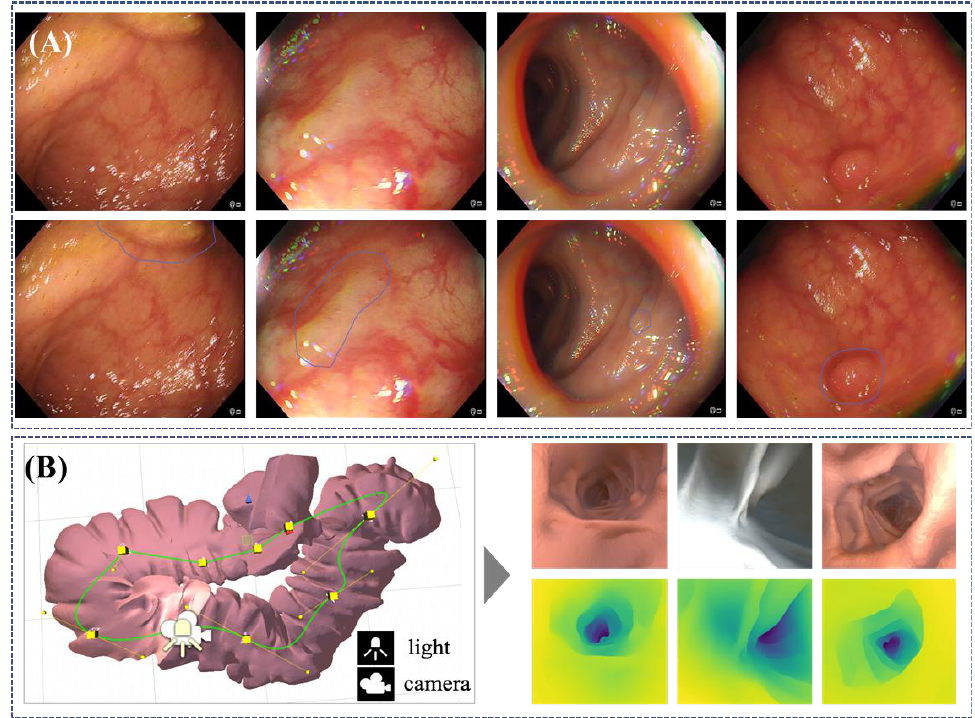
Figure 7. Illustration of the use of AI techniques on endoscopic images. ( A ) Shows an AI model that automatically highlights regions in the endoscopic images which are potentially occupied by a polyp; (top) original images, and (bottom) images with AI predicted regions (Courtesy of Prof. Danail Stoyanov). ( B ) Shows simulation data generated for a virtual colon, which can be used toward unsupervised AI models that can predict information that is not normally available such as depth. The image on the left shows examples of synthetic images from the simulation and depth maps predicted using an AI model where the darker colour illustrates further away from the image, whereas the image on the right shows examples of rendered RGB images with corresponding depth maps generated along camera path [172]. 6. Discussion and Conclusions Since its introduction in the clinical practice, colonoscopy has been honed to a highly effective diagnostic and therapeutic modality that has transformed provision of GI healthcare and it became one of the main pillars of an entire specialty. However, the main advantage of the procedure remains one of its main drawbacks, i.e., the need to push a flexible endoscope from the anal orifice to the caecum with all that entails in terms of discomfort and complications for patients. We are living in an era of change, both in terms of fast pace developments in precision/personalised medicine, as well as technological delivery since the dawn of the millennium. We are living the “ belle epoque ” of start- ups, digitalisation and resurge of AI; furthermore, there is a lot of interest in ways to eliminate human impact on the environment and reduce the mistakes in healthcare services delivery together with some added efforts to “equalise” healthcare provision across the globe. What is perhaps most relevant at the moment is the fact that novel infectious agents, e.g., SARS-CoV-2, are disrupting our normal living conditions, the global economy and they are posing a major threat to human life either directly or indirectly through an immense strain placed on the shrivelling healthcare resources, and this calls for implementation of measures such as “ social and medical distancing ” . In this environment, the interface between machines/robots and humans, present at the receiving end of services, is becoming smoother and their resistance of acceptance is curbed. In this era, the use of robotic adjuncts or full robotization/automatization of the procedure are major contributions to explore , such as for guaranteeing the “social and medical distancing”. We should not forget though